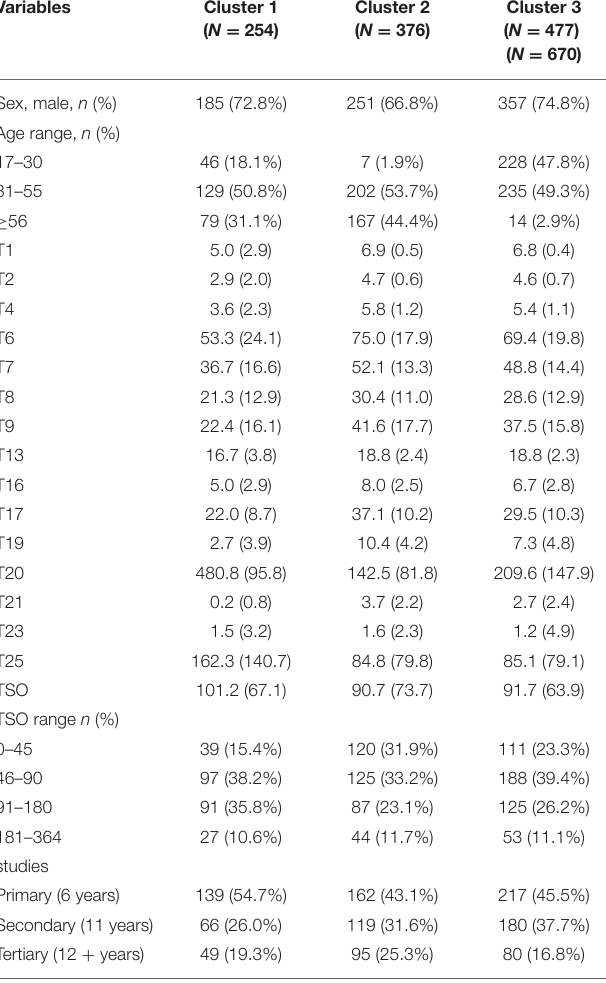
TABLE 5 | Kproto results considering the variables not used for creating the clusters. Variables